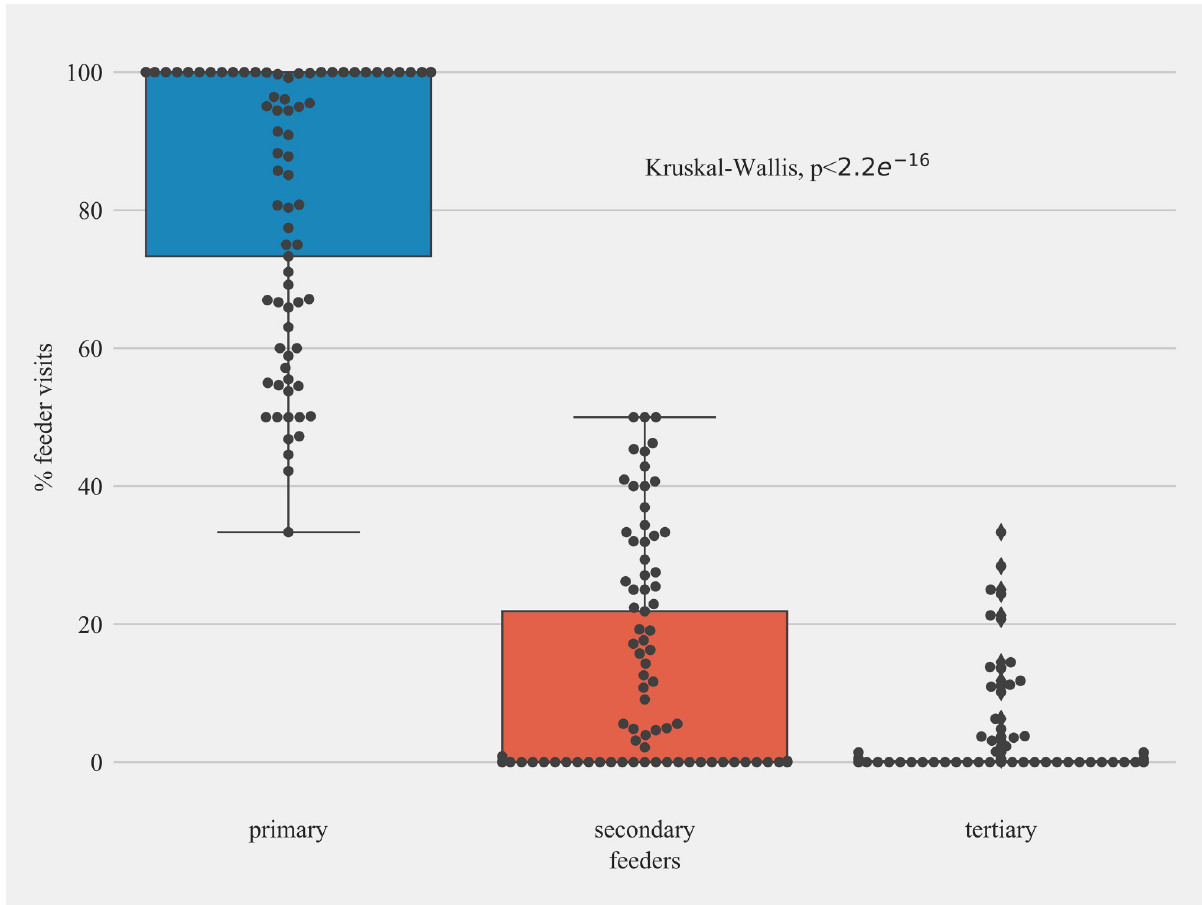
Fig 7. Feeder visit percentages for individual Anna’s and Allen’s Hummingbirds for primary, secondary, and tertiary feeders at Site 2 in Northern California. Solid circles show the data points.